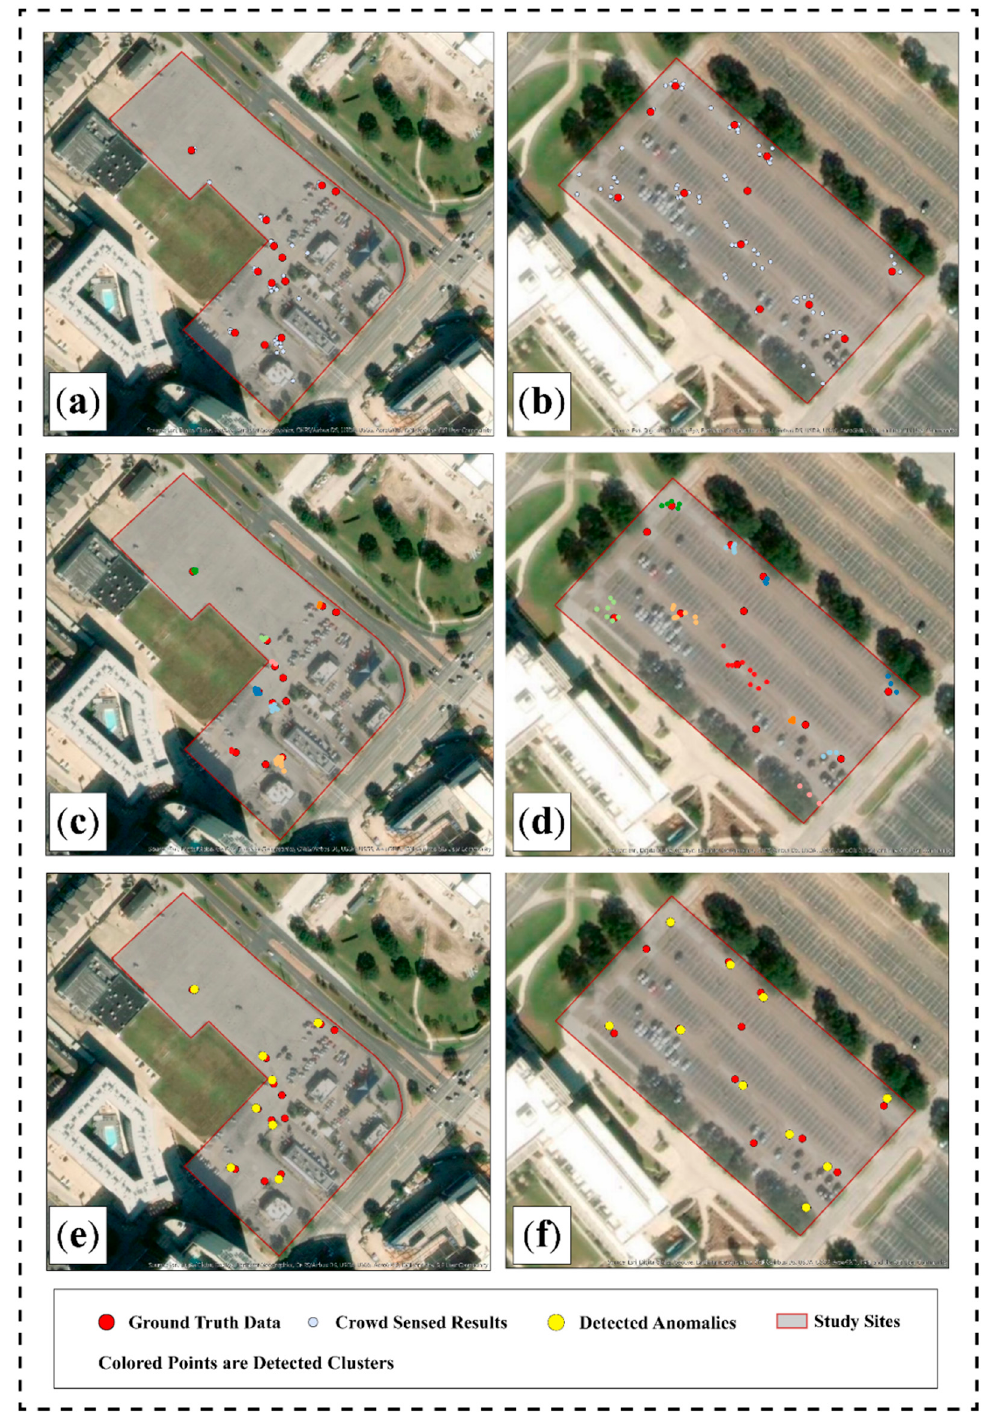
Figure 9. Crowd sensed data integration results: ( a ) and ( b ) are detection results of five driving tests for two study sites; ( c ) and ( d ) show the clustering results after eliminating low-quality contributed points; ( e ) and ( f ) are the optimized detection results by synthesizing each cluster’s member points.